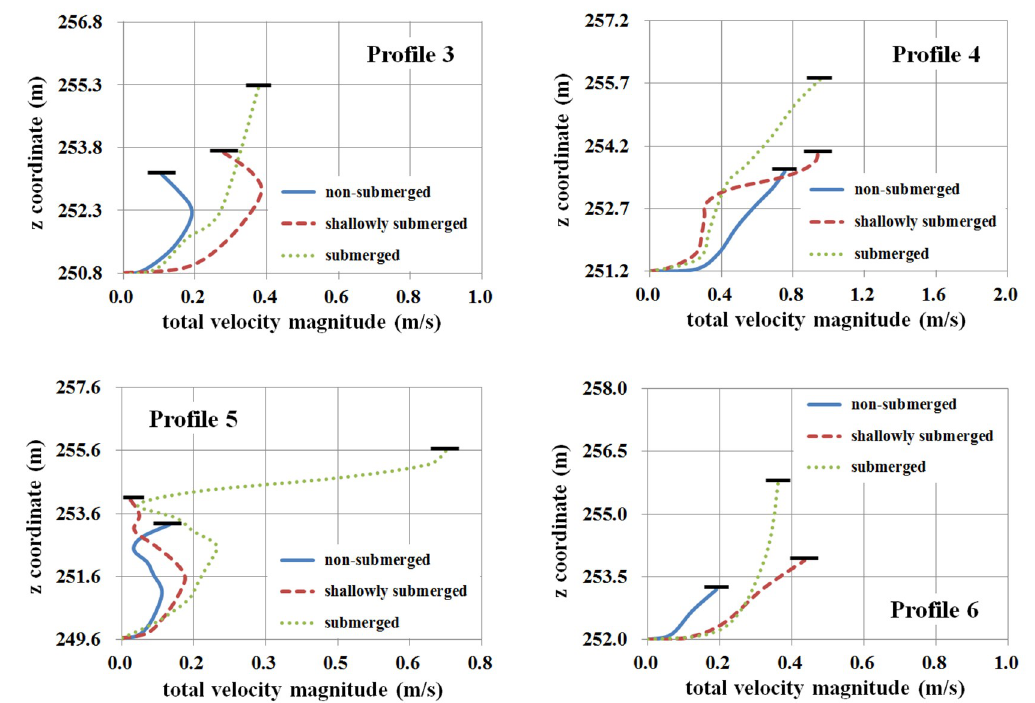
Figure 10. Vertical velocity profiles of the six selected locations for three different flood stages around the double-spur dikes.